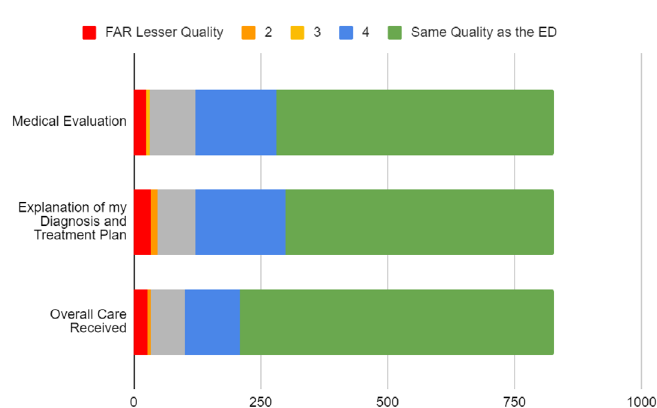
Figure 2. Patients’ perception of the quality of care received compared to their expected care in the emergency department.